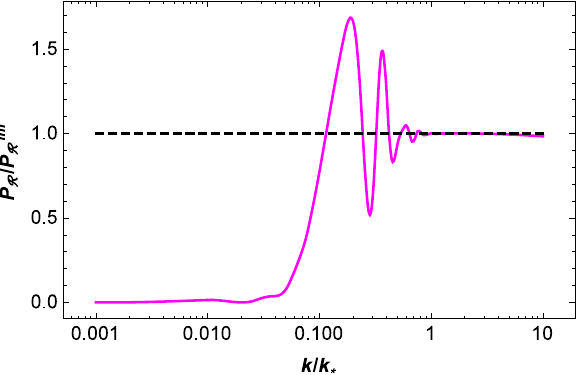
Fig. 5 The spectrum P R of the scalar perturbation, while we set f 1 = 5, f 2 = − 0 . 23, f 3 = − 13 f 2 , q 1 = 1, q 2 = 0 . 2, q 3 = 0 . 2, q 4 = 2, λ = 4 × 10 − 4 , φ = 7, φ = 22 . 7, φ = 5 . 2 and k ∗ corresponds to 0 1 2 the comoving wave number of the perturbation mode which exits the horizon around the beginning of inflation